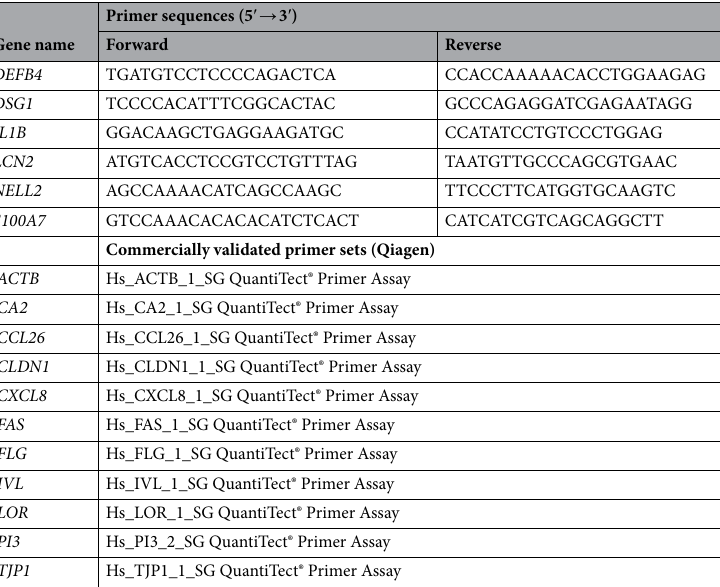
Table 1. Primer sequences and purchased primer sets. Oligonucleotide sequences used for expression analysis of the genes DEFB4 (defensin, beta 4), DSG1 (desmoglein-1), IL1B , (interleukin-1 beta), LCN2 (lipocalin-2), NELL2 (neural epidermal growth factor-like like 2), S100A7 (psoriasin) are listed in 5’-3’ direction. Validated primer sets were purchased from Qiagen to examine the gene expression of ACTB (beta-actin), CA2 (carbonic anhydrase), CCL26 (C–C motif chemokine ligand 26/eoatxin-3), CLDN1 (claudin-1), CXCL8 (C-X-C motif ligand 8/interleukin-8), FAS (Fas cell death receptor), FLG (filaggrin), IVL (involucrin), LOR (loricrin), PI3 (peptidase inhibitor 3/elafin) and TJP1 (tight junction